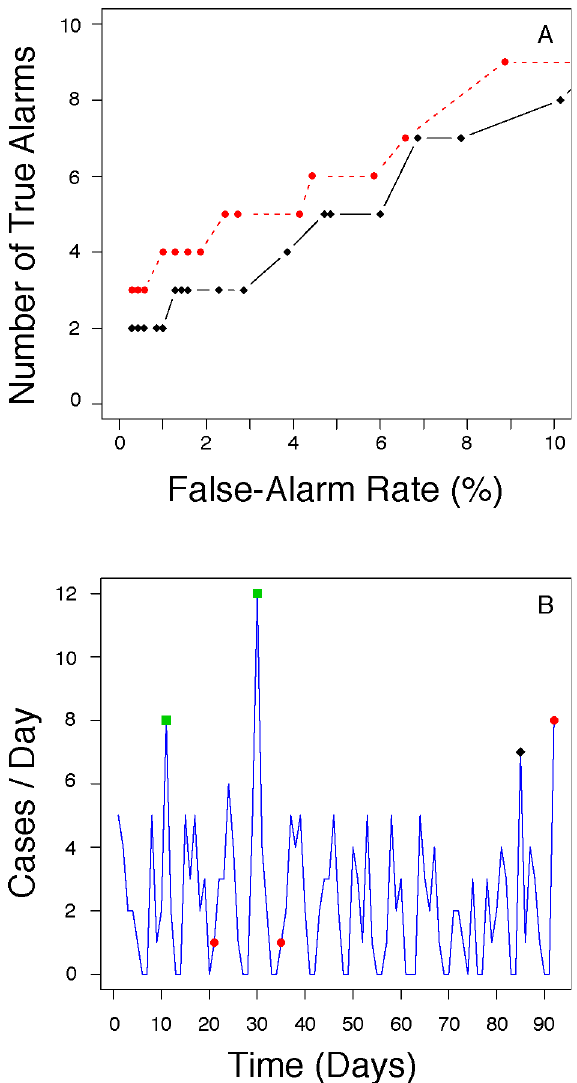
Fig 4. Performance comparisons: pH1N1 pandemic. Panel A: Number of true-positive alarms (y-axis) as a function of daily FAR (x-axis) for the full summer of 2009 comparison period. Note that SARIMA (red circles) issued more true alarms than EARS (black diamonds) at any FAR. Panel B: Daily counts of authentic ARI cases (y-axis) during the summer of 2009 comparison period (x-axis). True alarms at a 3% FAR were issued by SARIMA alone on the days highlighted by red circles, EARS alone (black diamond) or by both SARIMA and EARS (green squares). Note that the first alarm of the time period is recognized by both statistical approaches (see text).